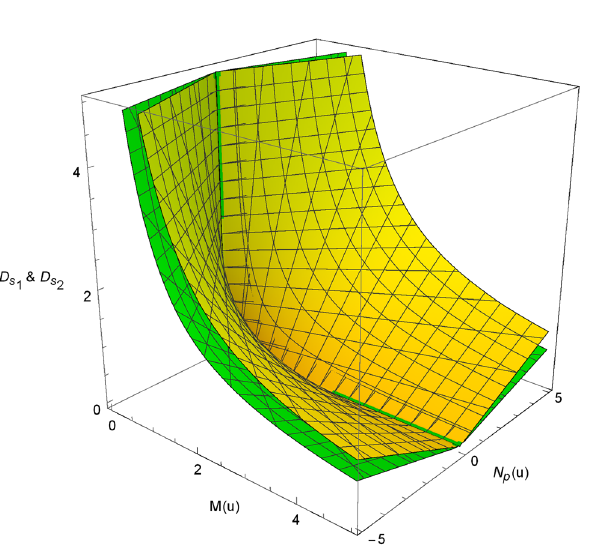
(green plot) and D s 1